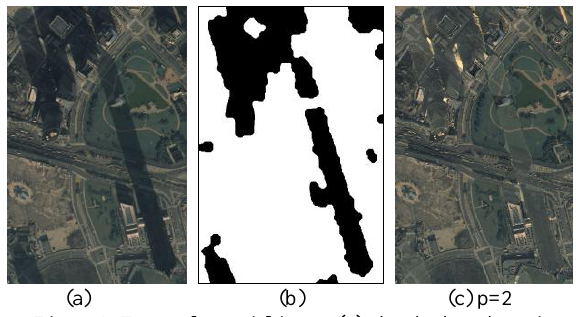
Figure 2. True color aerial image (a), the shadow detection result (b) and the results of shadow removal (c) Figure 2 (a) is the original image. Figure 2 (b) is the shadow detection result; the black area is shadow region (note a few errors at the edge of shadow region). Figure2 (c) is the shadow removal image when p is 2.